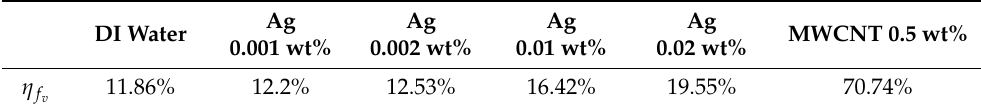
Table 1. Photothermal conversion efficiency of different